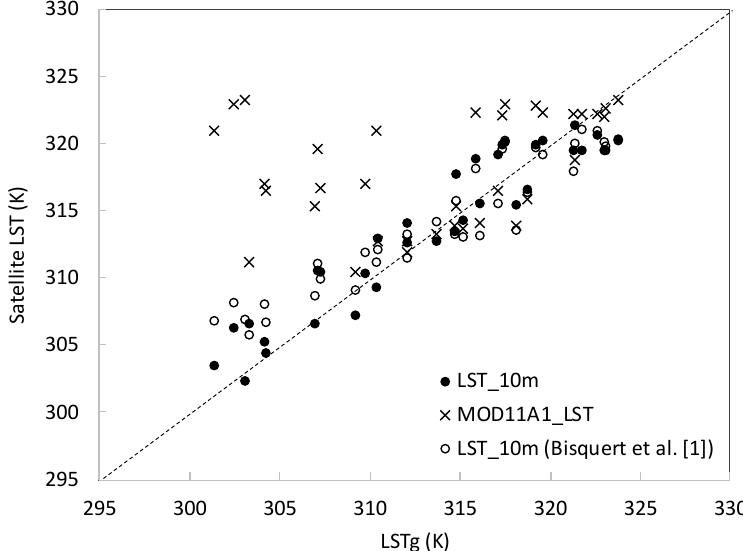
Figure 6. Disaggregated LST 10m (dots) and Moderate Resolution Imaging Spectroradiometer (MODIS) LST (crosses) versus ground LST measurements (LST g ). Non-filled dots represent results using the original Bisquert et al. [1] formulation of the downscaling approach. Error bars are not included in this figure for cleanliness. Dashed line represents the 1:1 agreement. Table 2. Quantitative analysis of the differences between disaggregated LST or MODIS LST, and ground-measured LST data. The statistics include: mean bias (Bias); standard deviation (SD); mean absolute deviation (MAD); Mean Absolute Deviation in Percentage (MADP), obtained as the MAD divided by the mean observed value; root mean square difference (RMSD); coefficient of determination (r2); median bias (Me); robust standard deviation (RSD); robust RMSD (R − RMSD); skewness (S); and kurtosis (K).